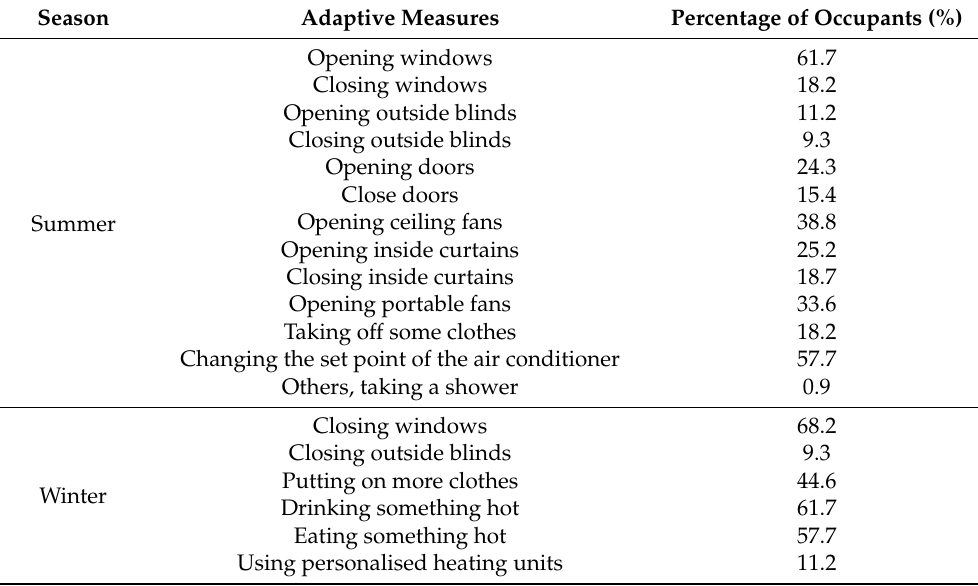
Table 1. Adaptive measures taken by occupants to modify the indoor environment in summer and